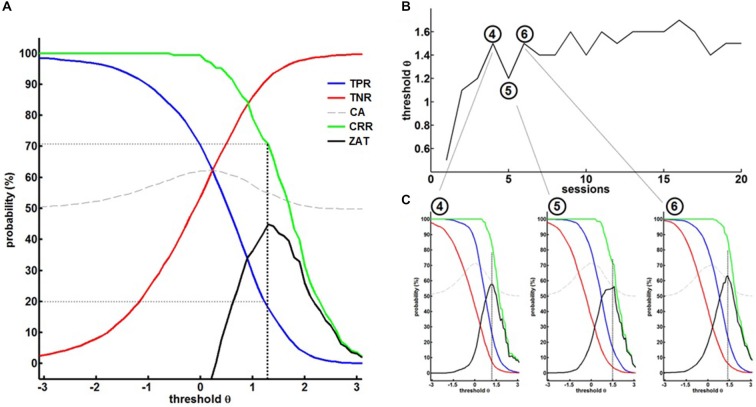
(A) Off-line re-analysis of the BMI data in the first session for different thresholds θ providing the true-positive rates (TPR), true-negative rates (TNR), classification accuracy (CA), correct response rate (CRR) and the zone of adjusted threshold (ZAT). ZAT peaks at θ = 1.2 corresponding to TPR = 20.9%, FPR = 9.9% and CRR = 72.2%. Hence, θ = 1.2 was selected for the succeeding BMI session. (B) Shows BMI thresholds in the course of training. (C) Exemplary off-line analysis after session 4, 5 and 6 illustrating on the evolution of BMI performance.